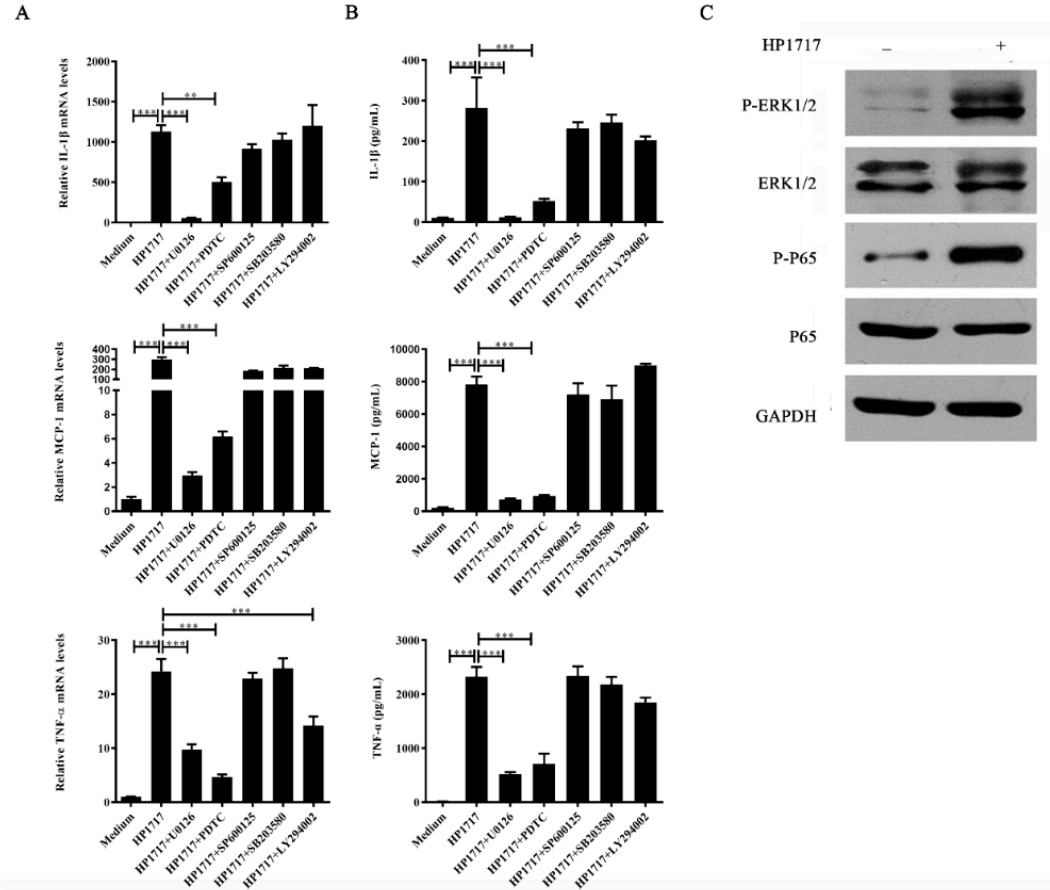
Figure 5. Signal transduction pathways of the HP1717-stimulated pro-inflammatory response in RAW 264.7 macrophages. After pretreatment with inhibitors of ERK1 / 2 (U0126), NF- κ B (PDTC), JNK (SP600125), p38 MAPK (SB203580), or PI3K (LY294002) for 30 min, RAW 264.7 macrophages were stimulated with 1 µ g · mL − 1 HP1717 for 6 h. ( A ) The cytokine mRNA levels were determined by qRT-PCR, and ( B ) the protein levels of IL-1 β , MCP-1, and TNF- α in the culture supernatants were determined by ELISA. ( C ) HP1717-induced phosphorylation of NF- κ B and ERK 1 / 2 MAPK in RAW264.7 macrophages: RAW264.7 macrophages were stimulated with HP1717 (1 µ g · mL − 1 ) for 6 h. The cell lysates were analyzed by Western blotting using specific antibodies against P65, phospho-P65, ERK 1 / 2 MAPK, and phospho-ERK 1 / 2 MAPK. GAPDH was detected as an internal control using an anti-GAPDH antibody. The results shown are representative of three independent experiments. ** p < 0.01, *** p < 0.001.